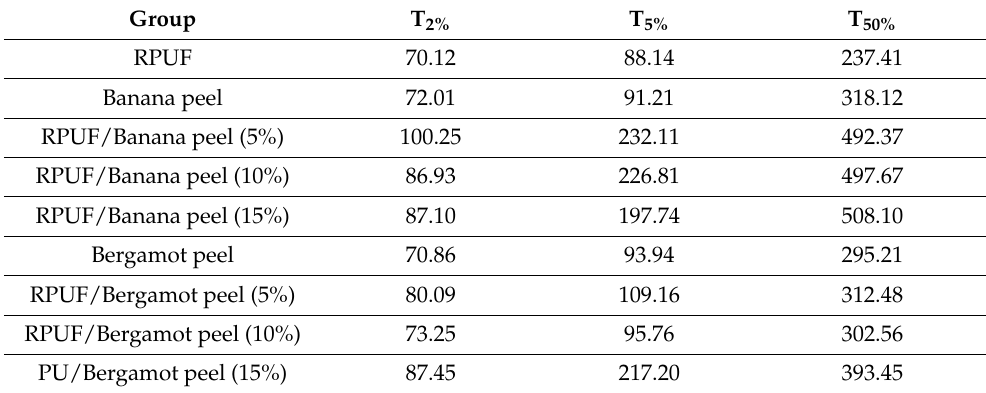
Table 2. Main thermal events evaluated by TG analysis of the studied